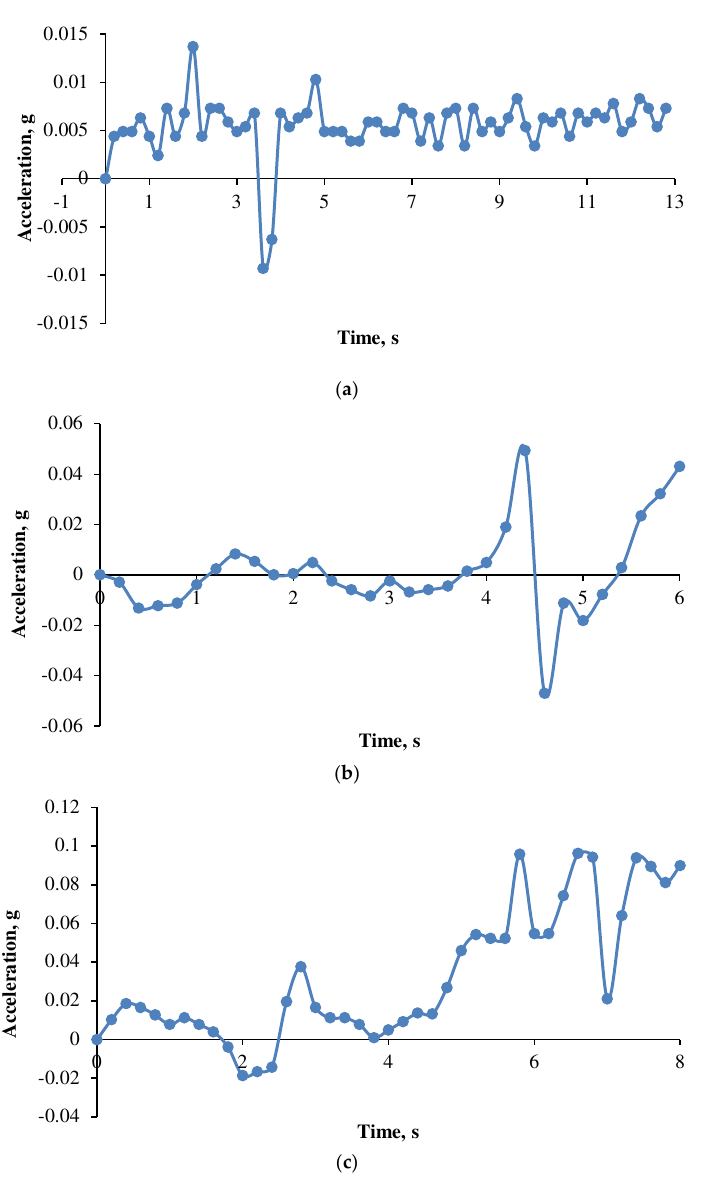
Figure 22. The maximum acceleration from AC3 for: ( a ) test 1 with 1 m water level; ( b ) test 2 with 2 m water level; ( c ) test 3 with 3 m water